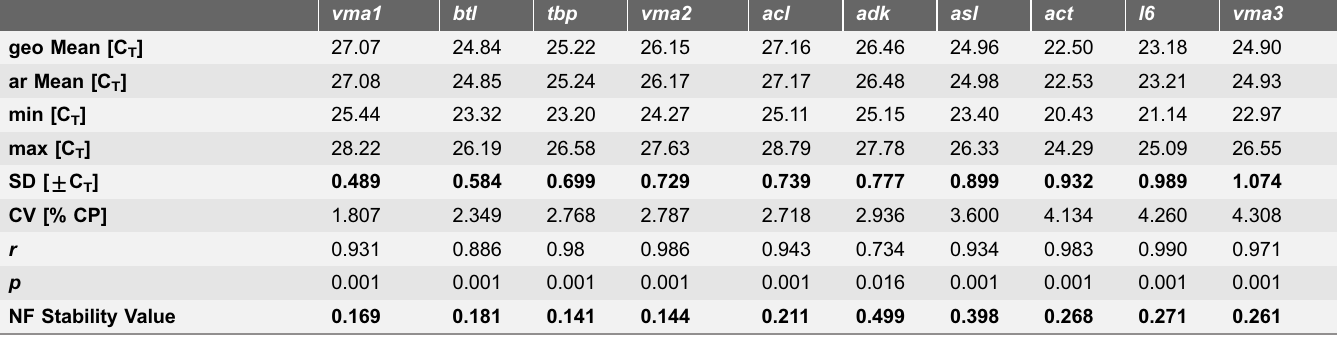
Table 3. Descriptive statistics and stability values of candidate reference genes under all-dark conditions (n 5